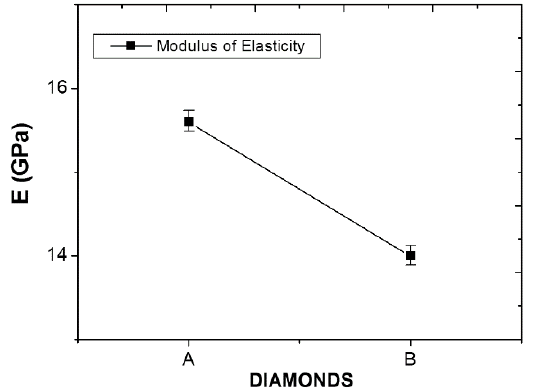
Figure 8. Modulus of Elasticity of diamond composites. A: uncoated diamonds composites and B: TiC coated diamonds composites.